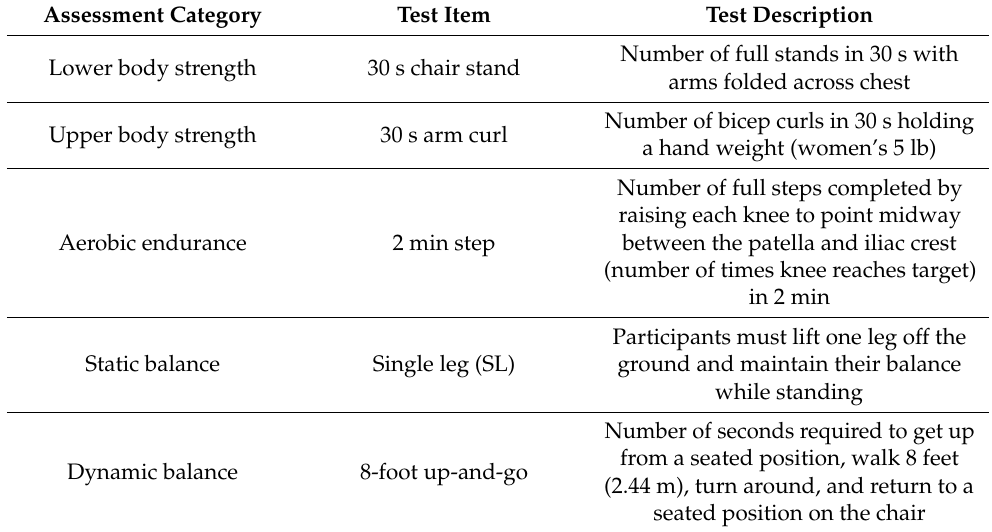
Table 3. Brief description of SFT